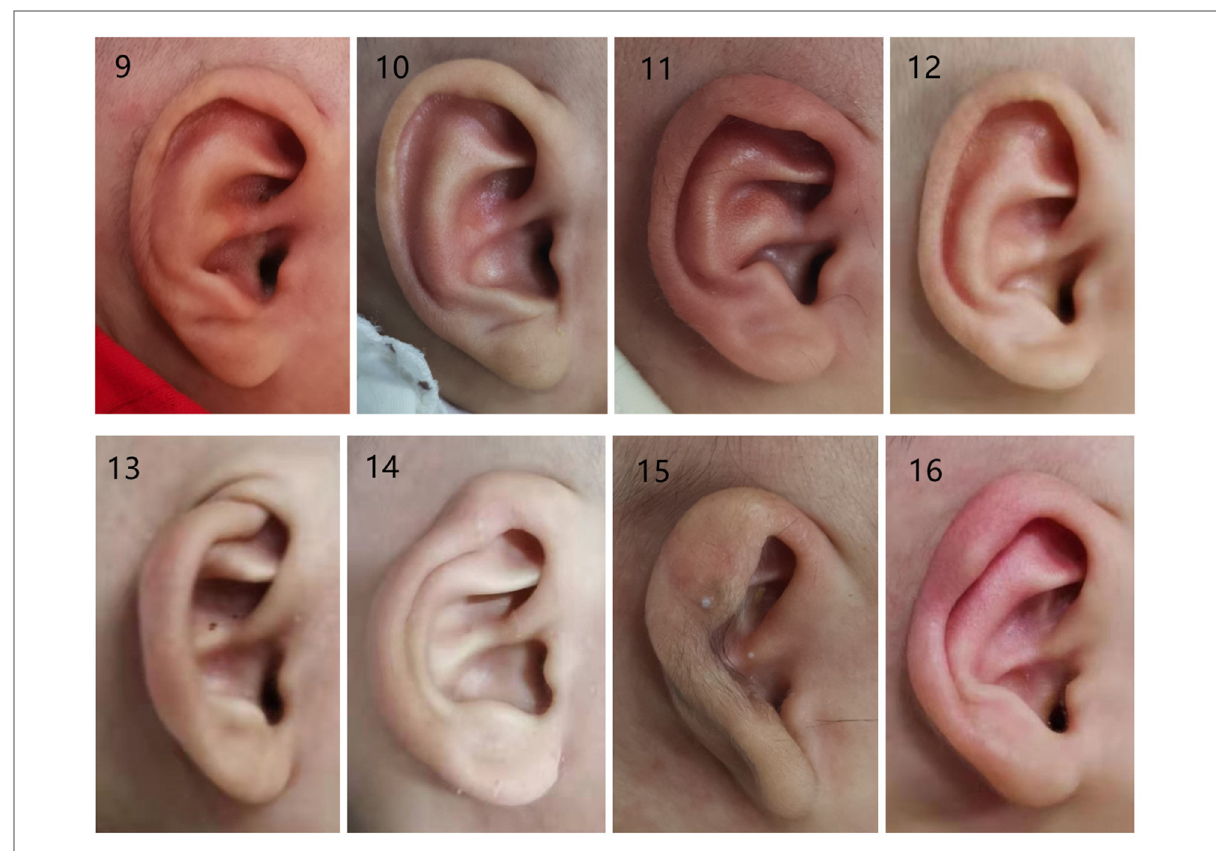
FIGURE 4 Photographs of congenital ear deformities before and after treatment (part II): (9 and 10) before and after treatment of the prominent conchal crus, (11 and 12) before and after treatment of mixed deformities, (13 and 14) before and after treatment of the cryptotia, (15 and 16) before and after treatment of the constricted ear.